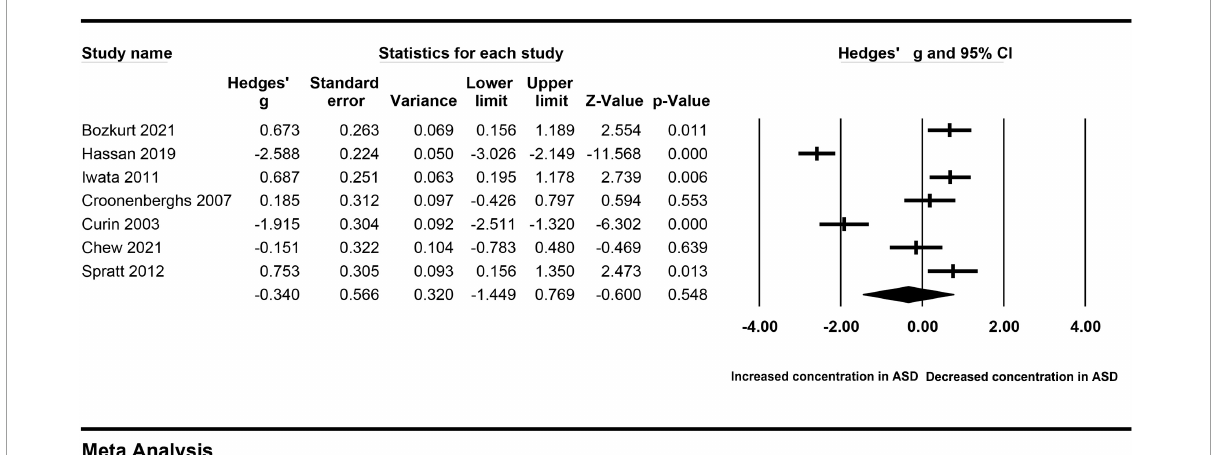
FIGURE3 Forest plot for the random-effect meta-analysis of the serum subgroup.